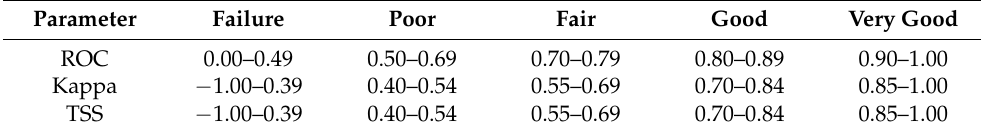
Table 3. Criteria for the measurement of prediction accuracy for ecological niche